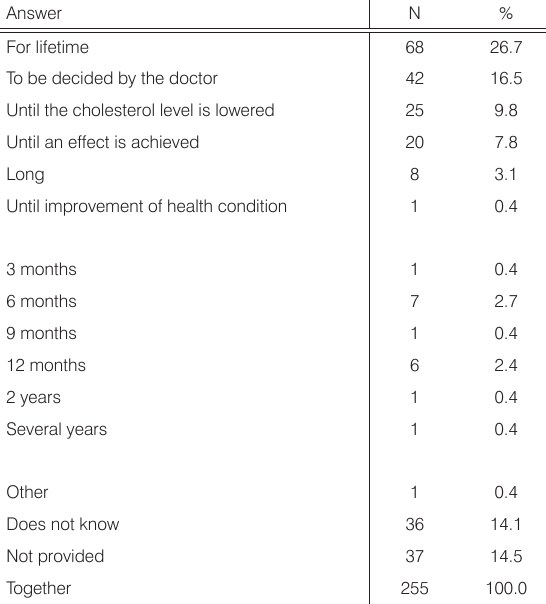
Table 5. Type of assistance that the respondents would expect from their doctor in order to help them adhere to their lipid- lowering medication.